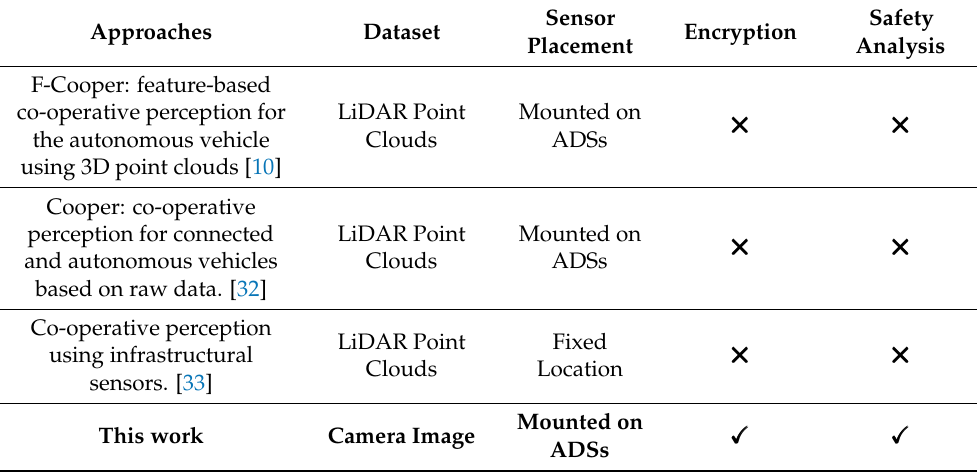
Table 3. Comparison with existing